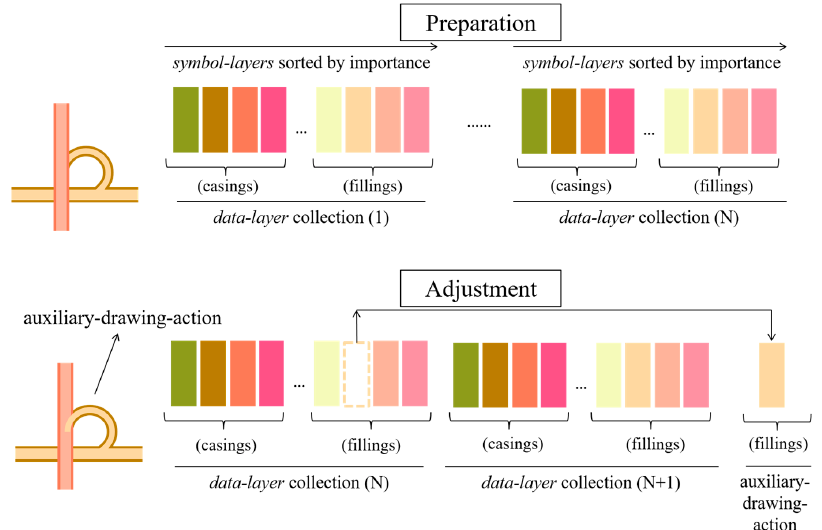
Figure 11. Flowchart of the automatic rendering process for road networks